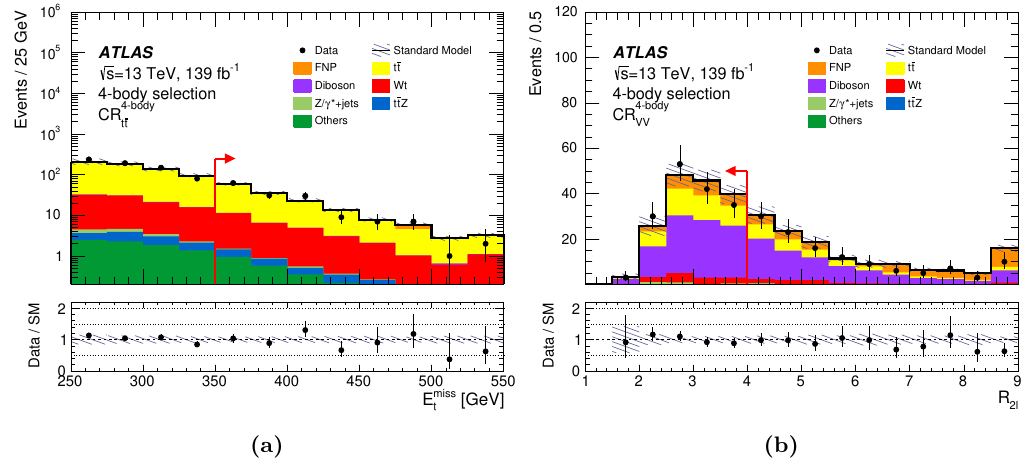
(a) Figure 6 . Four-body selection. Distributions of (a) E miss in CR 4-body and (b) R in CR 4-body after T 2 ‘ V V tt the background fit. The contributions from all SM backgrounds are shown as a histogram stack. “Others” includes contributions from V V V , tt t , tttt , tt W , tt WW , tt WZ , tt H , and tZ processes. The hatched bands represent the total statistical and detector-related systematic uncertainty. The rightmost bin of each plot includes overflow events. In the upper panels, red arrows indicate the control region selection criteria. The bottom panels show the ratio of the observed data to the total SM background prediction, with hatched bands representing the total uncertainty in the background